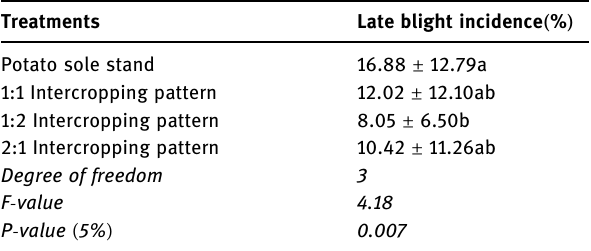
Table 5: Late blight incidence as in fl uenced by intercropping pattern Treatments